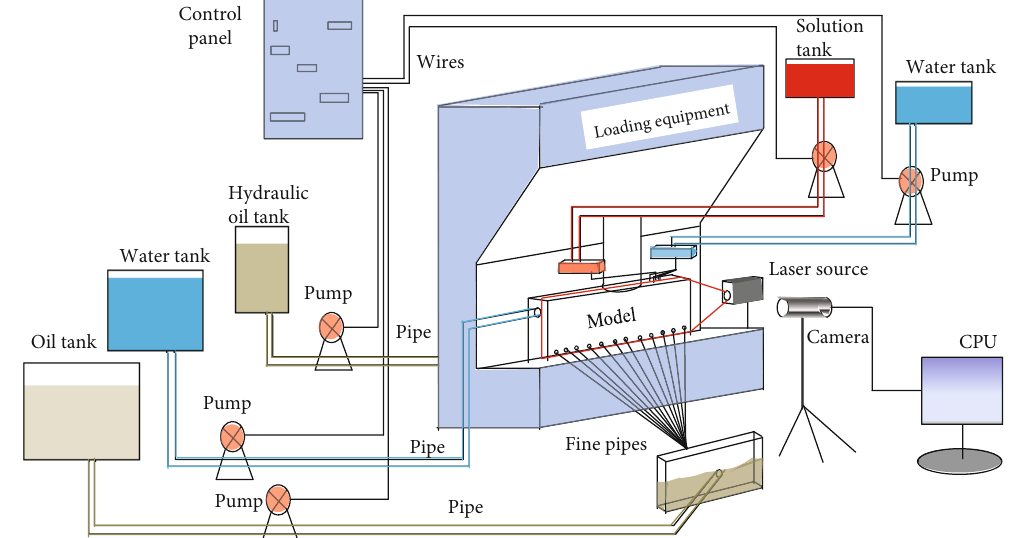
Figure 3: Schematic diagram of coordinated mining